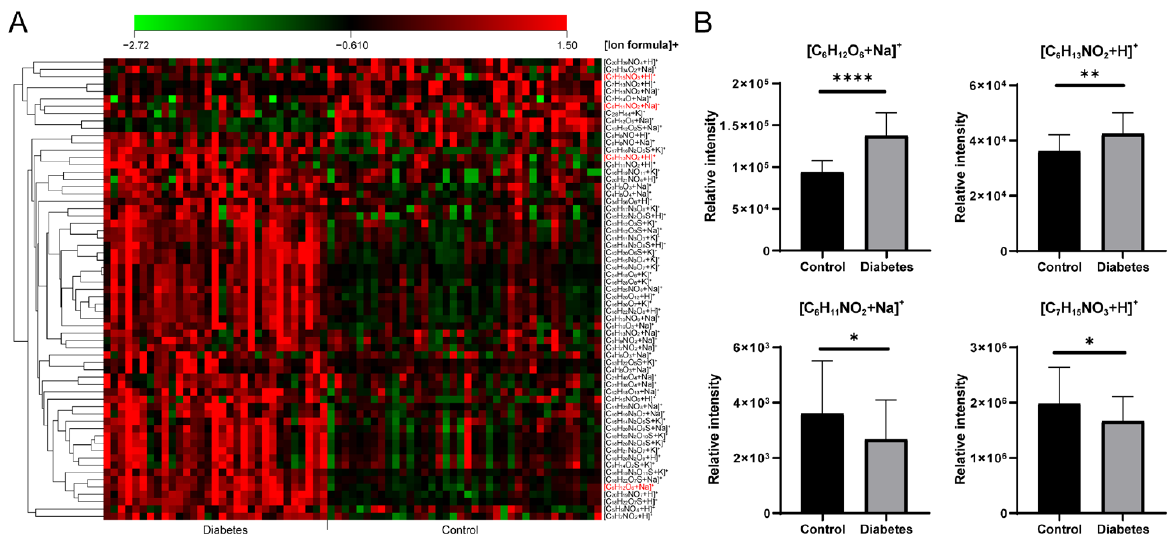
Figure 5. ( A ) The heat map of significantly changed ion formulas between control and diabetes groups, ( B ) Changes of [C 6 H 12 O 6 +Na] + , [C 6 H 13 NO 2 +H] + , [C 6 H 11 NO 2 +Na] + and [C 7 H 15 NO 3 +H] + be- tween control and diabetes groups, respectively. **** p < 0.0001, ** p < 0.01, * p <